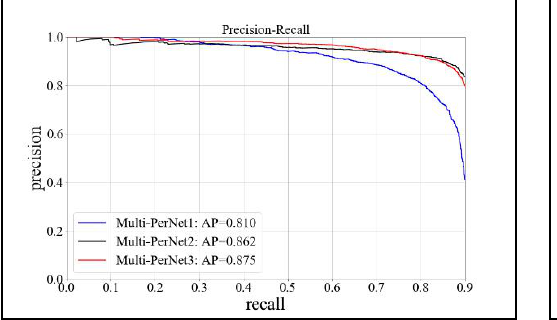
Figure 10. Comparison of three networks.